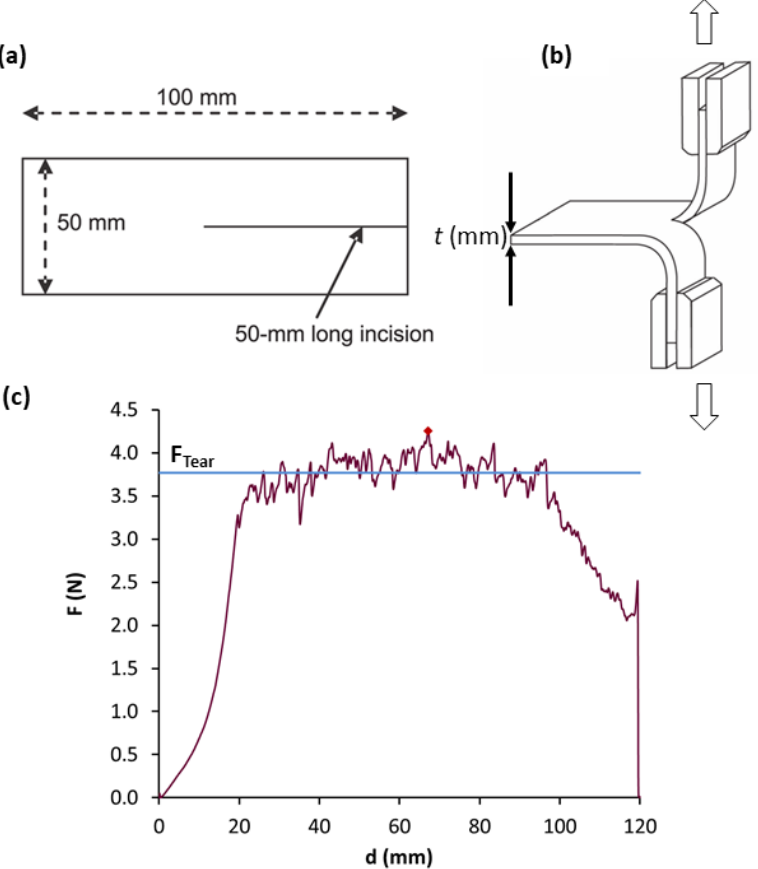
Figure 4. Sketch of the specimen ( a ), tear test direction ( b ) and determination of tear strength as the average tear force (F Tear ) per thickness ( t ) unit ( c ).